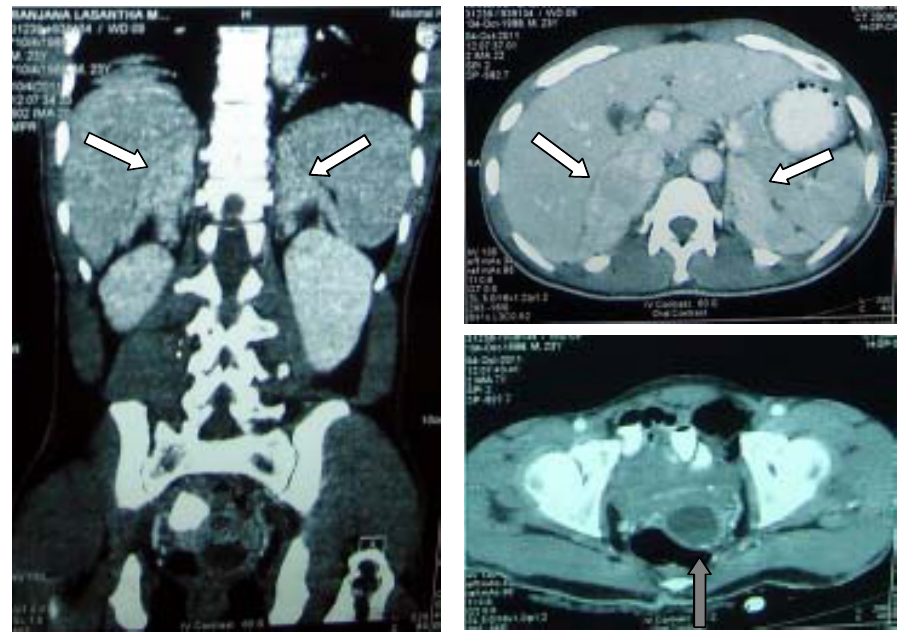
Figure 2 A and B – Bilateral adrenal hyperplasia (white arrows), C-Mullarian structures (grey